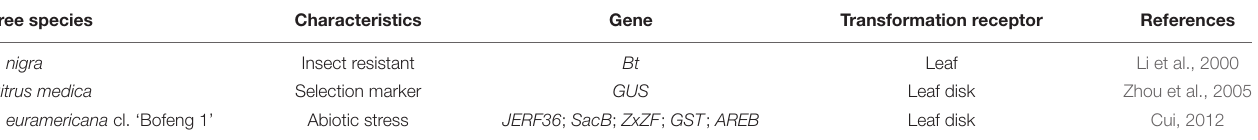
TABLE 3 | Gene gun-mediated transformation in different tree species. Tree species